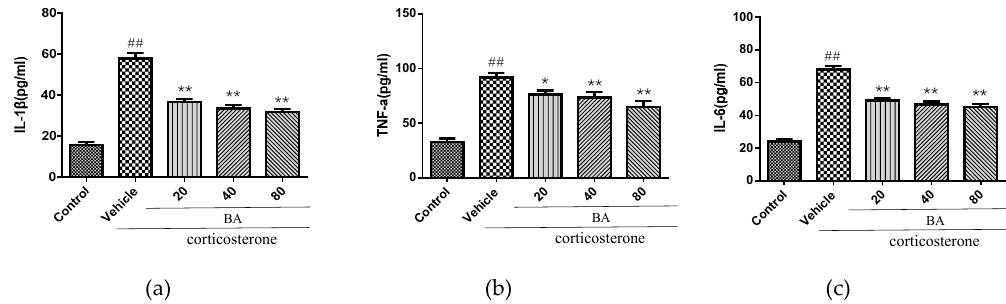
Figure 7. Effects of BA on cell viability in PC12 cells. ( A ) in the presence of corticosterone, ( B ) in the absence of corticosterone. Data were expressed as mean ± SEM ( n = 6). ## p < 0.01 vs. the control; ** p < 0.01 vs. the corticosterone group.